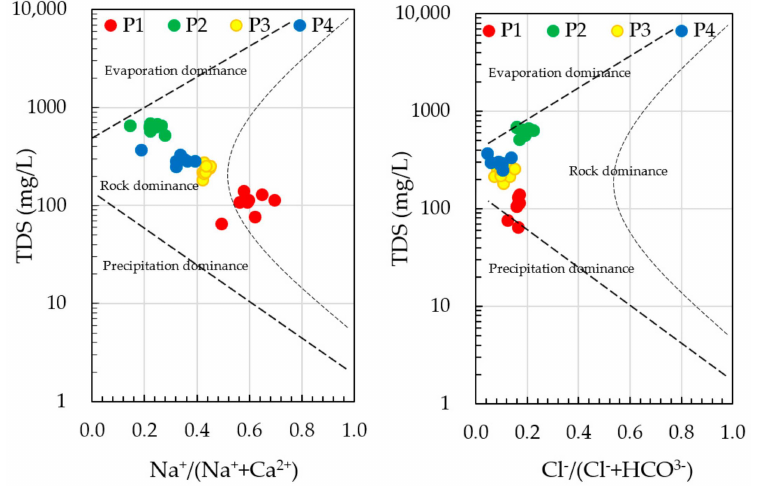
Figure 12. Gibbs diagram showing the source of cations and anions in the Cuernavaca aquifer at P1 (- • -), P2 (- • -), P3 (- • -) y P4 (- • -)